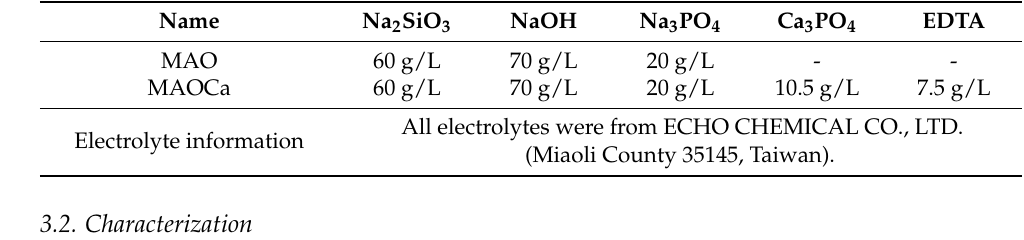
Table 5. Electrolyte composition and operating conditions for the MAO